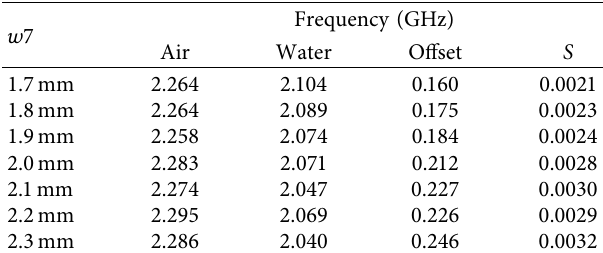
Figure 6: Resonant frequency of microchannels of different widths: (a) ε Table 1: Microfluidic channels of different widths affect antenna resonance frequency offset.